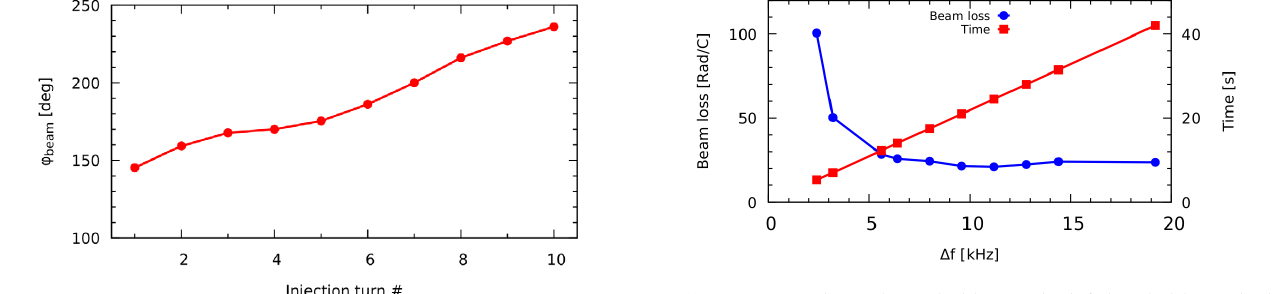
FIG. 12. Beam loss (shown in blue on the left-hand-side vertical axis) as a function of the frequency shift of the disabled SRF cavity. The time to move the cavity frequency (shown in red on the right-hand-side vertical axis) as a function of the amount of the frequency